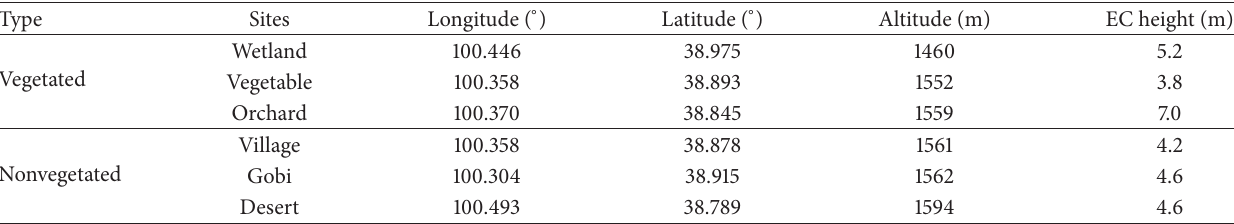
Figure 1: Geolocation of EC observation sites and illustration of land surface. Table 1: Descriptive information of EC sites.